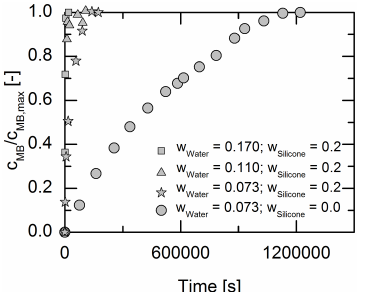
Figure 12. Effect of a silicone mass fraction of 0.2 in the PVA/silicone composite films of 170µm thickness on the MB con- centration profile for different water mass fractions in the PVA ma- trix at 298.15K (see correlation of water mass fraction and RH in Table 1).